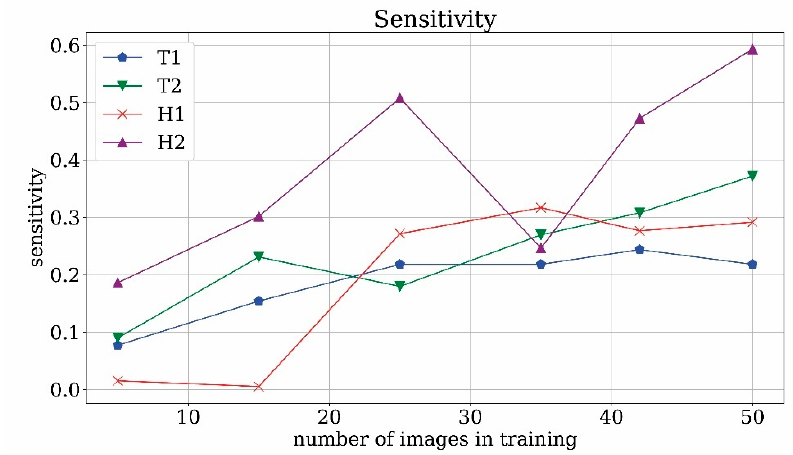
Figure 19. Sensitivity analysis evaluated on frames.